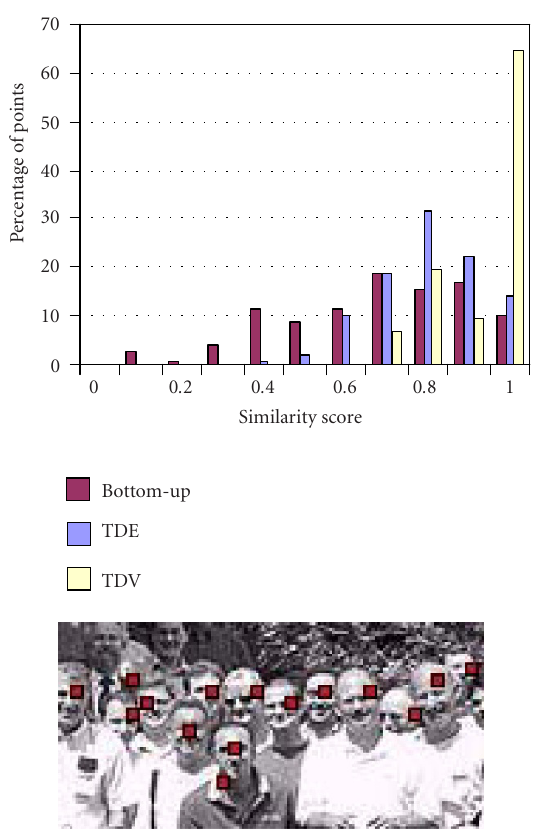
Figure 4: Percent of visited points according to the similarity score. The figure shows that a large portion of visited points have a low similarity score in bottom-up exploration, while in TDE and in TDV the visited points exhibit greater similarity scores. The im- age shows the result obtained with the face recognition task in TDV mode.